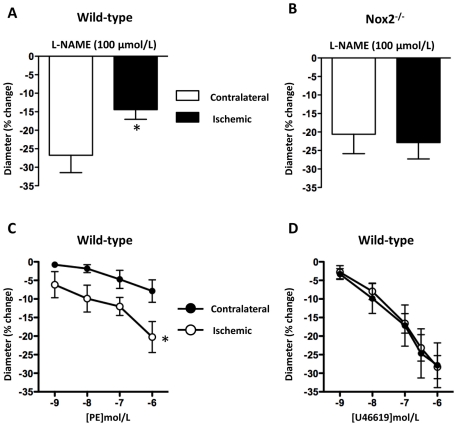
Effect of cerebral ischemia-reperfusion on vascular function.Vasoconstrictor responses of isolated contralateral and ischemic middle cerebral arteries (MCA) from wild-type (A) and Nox2-deficient (Nox2-/-; B) mice to L-NAME (100 µmol/L) 24 h after MCA occlusion. Also shown are vasoconstrictor responses of contralateral and ischemic MCA from wild-type mice to phenylephrine (PE: 1 nmol/L-1 µmol/L; C) and U46619 (1 nmol/L-1 µmol/L; D). Results are expressed as% change in intraluminal diameter and given as mean±SEM (A, n = 9 for contralateral, n = 10 for ischemic; B, n = 6 for contralateral, n = 6 for ischemic; C, n = 6 for contralateral, n = 4 for ischemic; D, n = 7 for contralateral, n = 6 for ischemic). *P<0.05 vs. contralateral MCA (A: unpaired t test; C: two-way ANOVA with a Bonferroni multiple comparison post-hoc test).